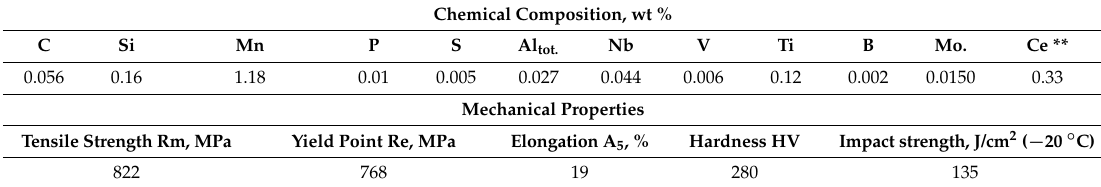
Table 1. The real chemical composition performed using Optical Emission Spectroscopy (OES) and the mechanical properties of the original S700MC steel material.